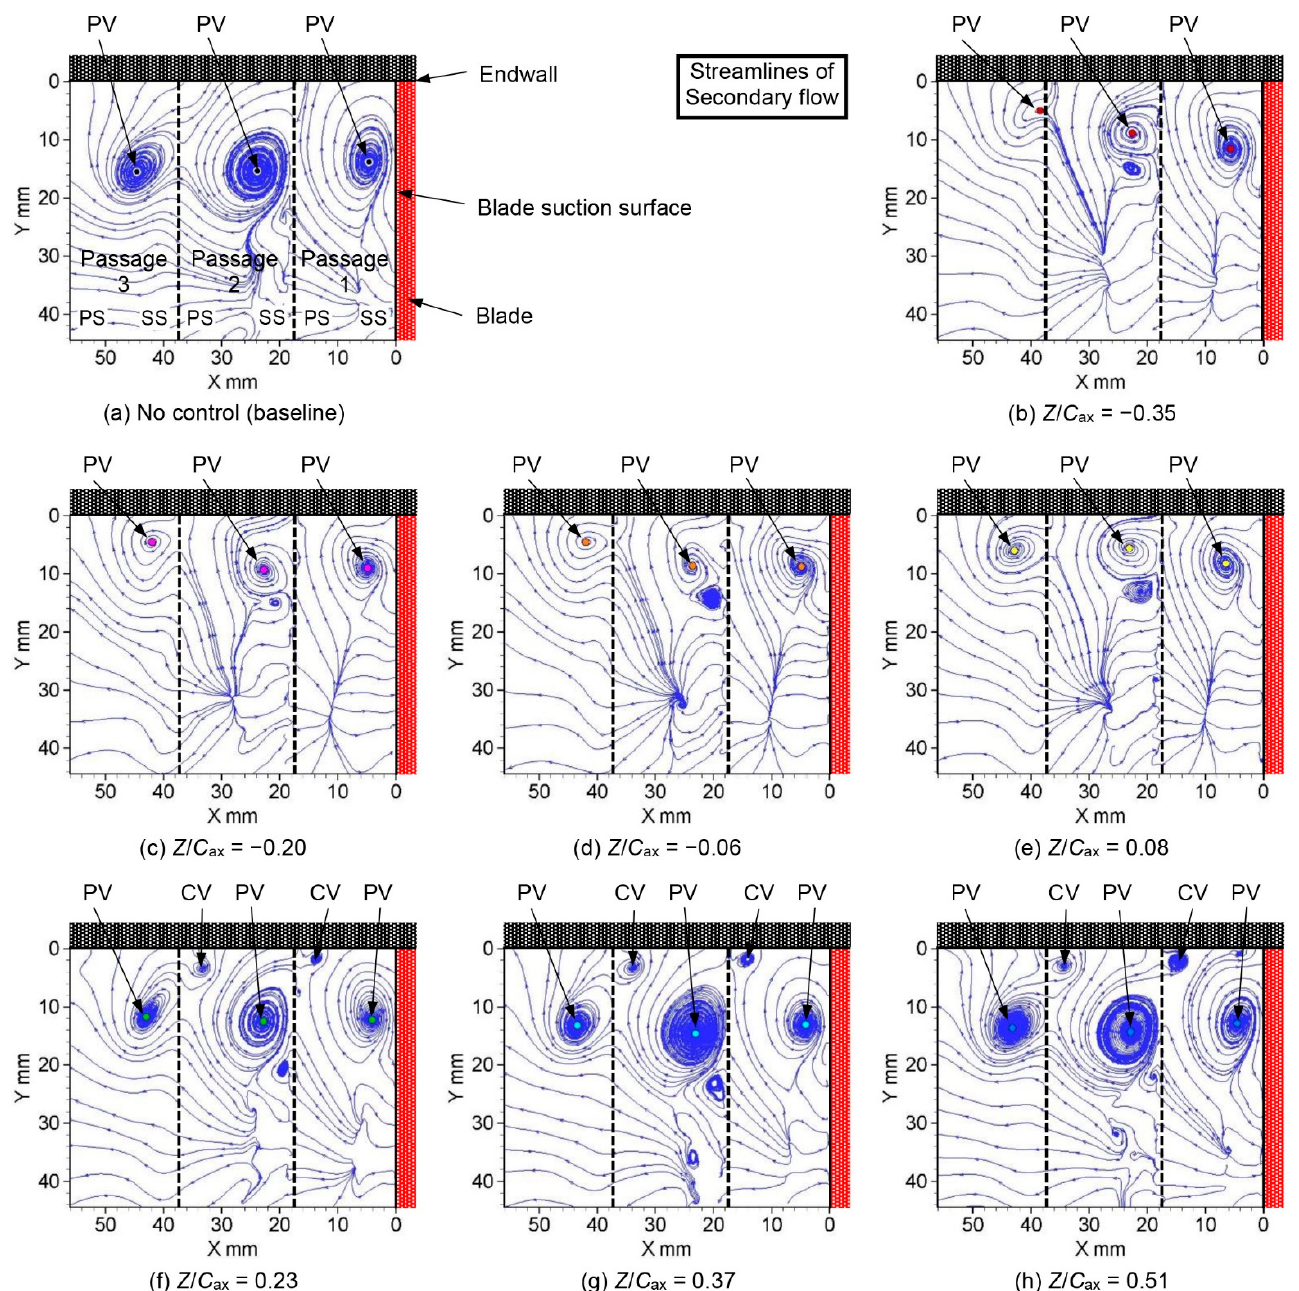
Figure 9. Streamlines of secondary flow at the outlet of the linear turbine cascade at various plasma actuator locations (Re out = 1.8 × 10 4 ).